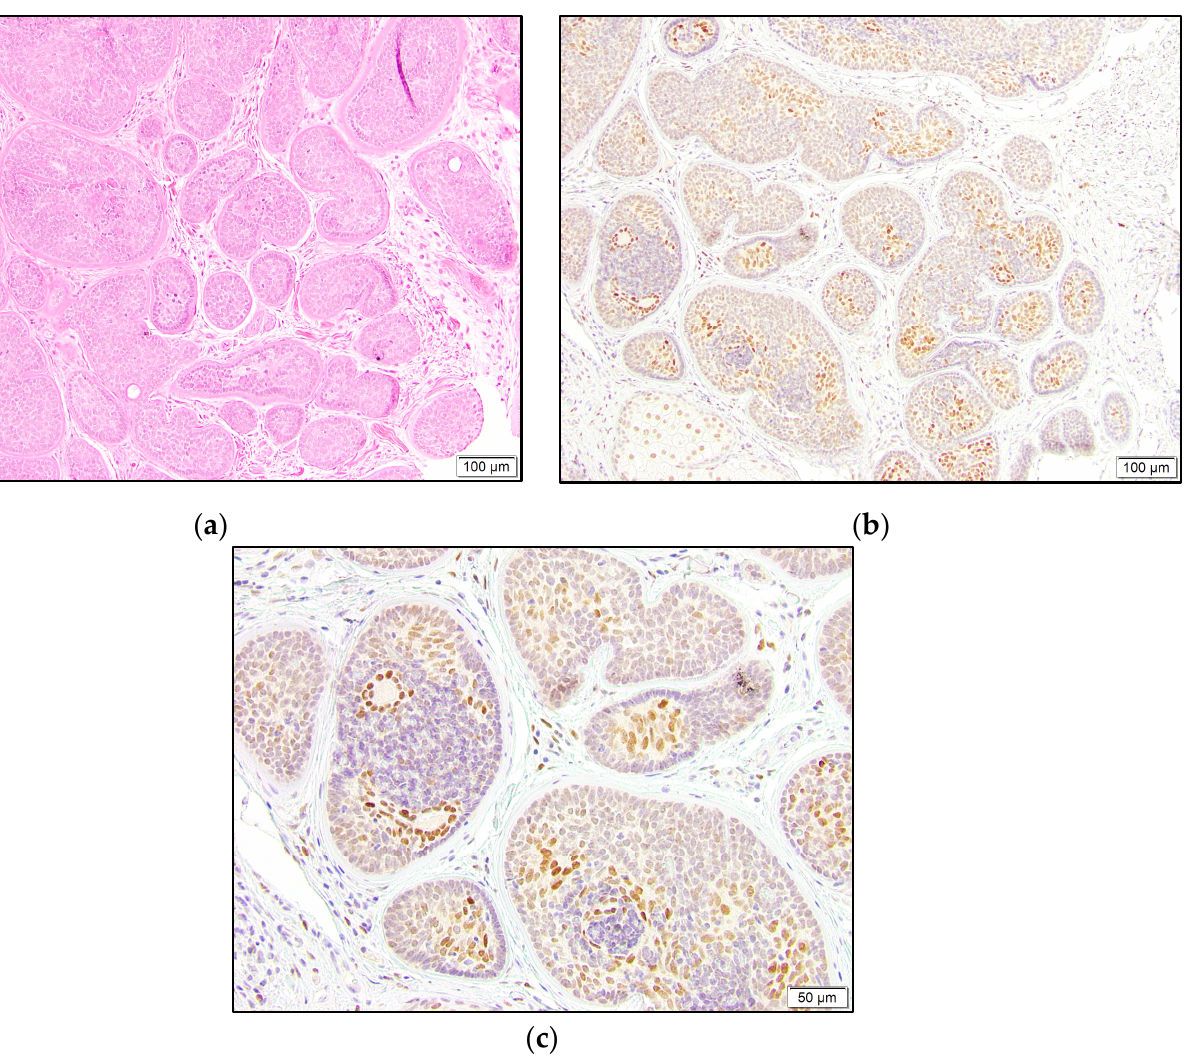
Figure 7. Cylindroma with islands of basaloid cells arranged in a jigsaw puzzle pattern ( a ). Strongest TRPS1 staining in luminal cells, weaker staining in surrounding neoplastic cells, and foci of negative staining with predilection for palisading cells ( b , c ).